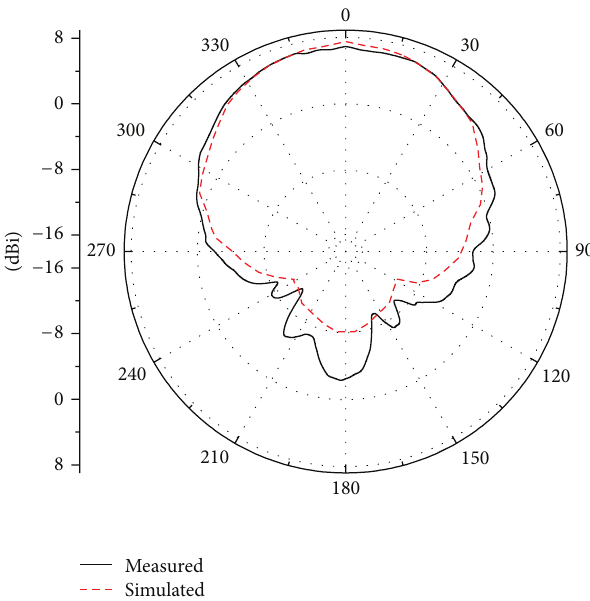
Figure 7: The simulated and measured radiation patterns at 922